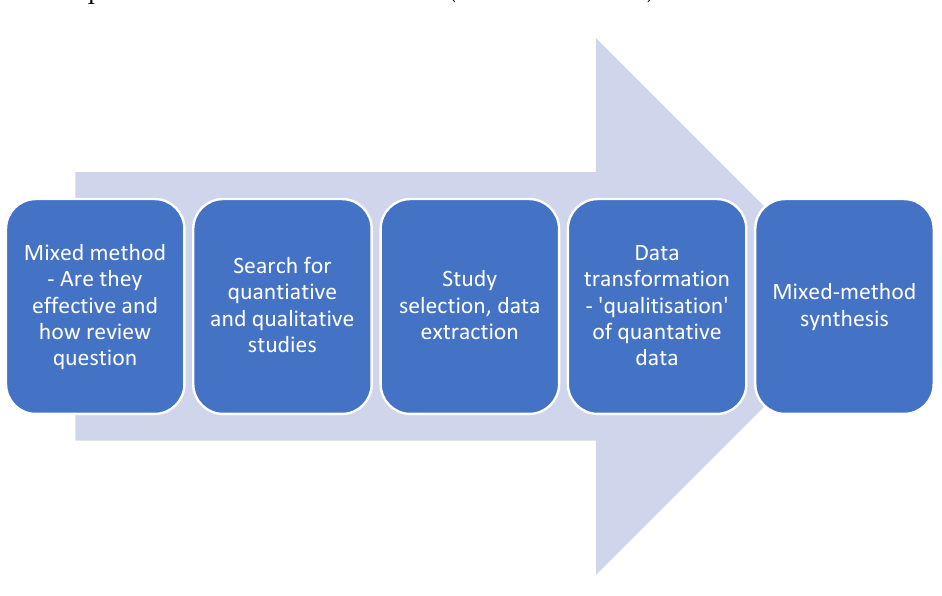
Figure 1. Figure adapted from convergent integrated approach [29].